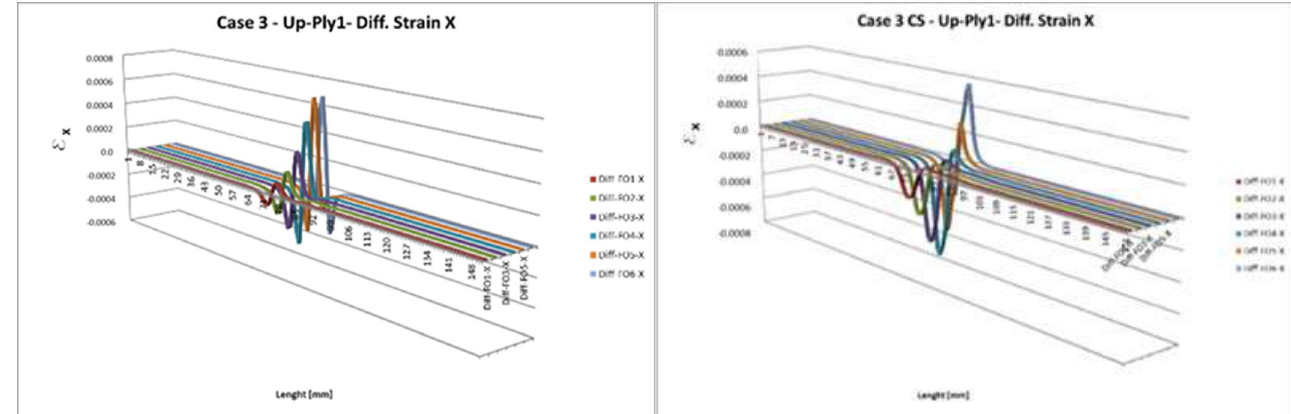
Figure 4. Difference of longitudinal strain on upper laminate: Ply 1 (external), symmetrical ( a ), and non-symmetrical load ( b ); Ply 15 (bonding interface), symmetrical ( c ), and non-symmetrical load ( d ).